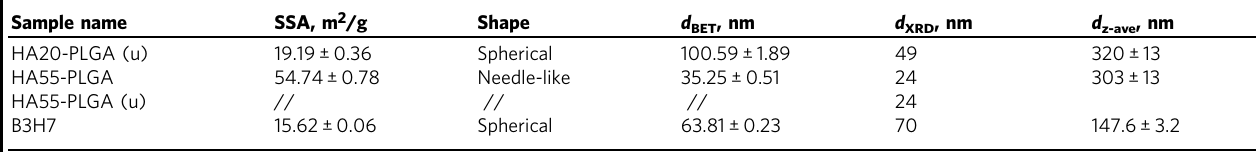
Table 1 Prepared polymer nanocomposite